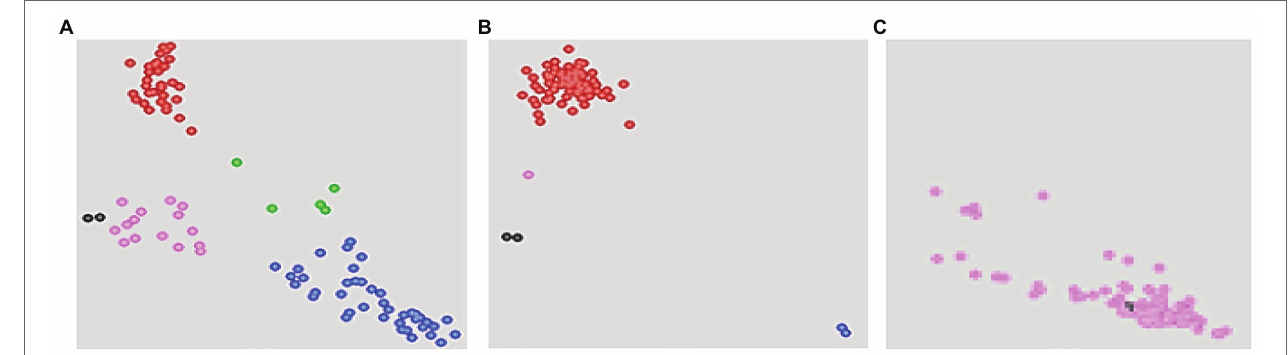
FIGURE 2 | Single nucleotide polymorphism (SNP) views showing cluster plots of BC 3 F 2 progeny and their parental lines for two SNP markers for resistance to MLN: (A) KASP cluster plots showing genotypes clustering for resistance (blue), susceptibility (red), and heterozygous (green) alleles. Unclassified DNA samples (purple) clustering toward the origin and closer to no treatment control (NTCs; black dots). The heterozygous genotypes (green) still segregate for MLN resistance alleles; (B) BC